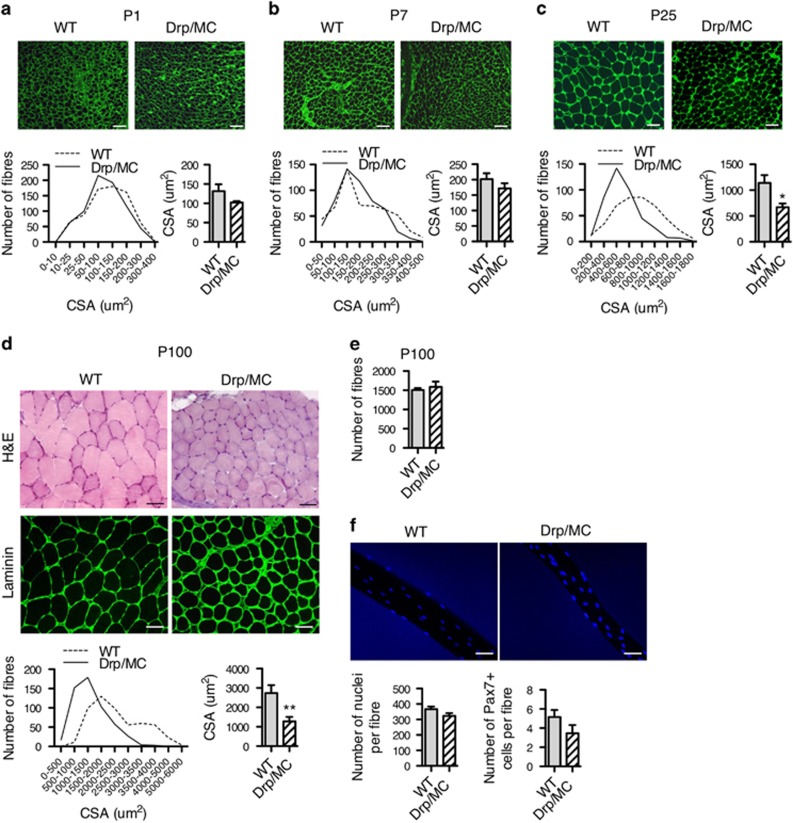
Muscle-specific Drp1 overexpression impairs postnatal muscle growth. (a, b, c) Representative images of immunofluorescence on TA sections from P1 (a), P7 (b) and P25 (c) mice by using a laminin-specific antibody. Original magnification x20, scale bar 50um. Frequency histogram showing the distribution of myofibre CSA in WT and Drp/MC TA muscles from P1 (a), P7 (b) and P25 (c) mice. Per condition, at least 500 fibres were counted. Mean myofibre CSA in WT and Drp/MC from P1 (a), P7 (b) and P25 (c) mice (n≥3 animals per genotype). (d) Representative sections of WT and Drp/MC TA muscles from P100 mice stained with H&E. Representative images of immunofluorescence on TA sections by using a laminin-specific antibody. Frequency histogram showing the distribution of myofibre CSA in WT and Drp/MC TA muscles from P100 mice. Mean myofibre CSA in WT and Drp/MC (n=3 animals per genotype). (e) Mean number of myofibres muscle (n=3 animals per genotype). (f) Mean number of myonuclei and Pax7 positive cells in WT and Drp/MC single fibres (n=4 preparations per genotype). Original magnification x20, scale bar: 50 μm. Error bars represent S.E.M. **P<0.01; *P<0.05 versus WT